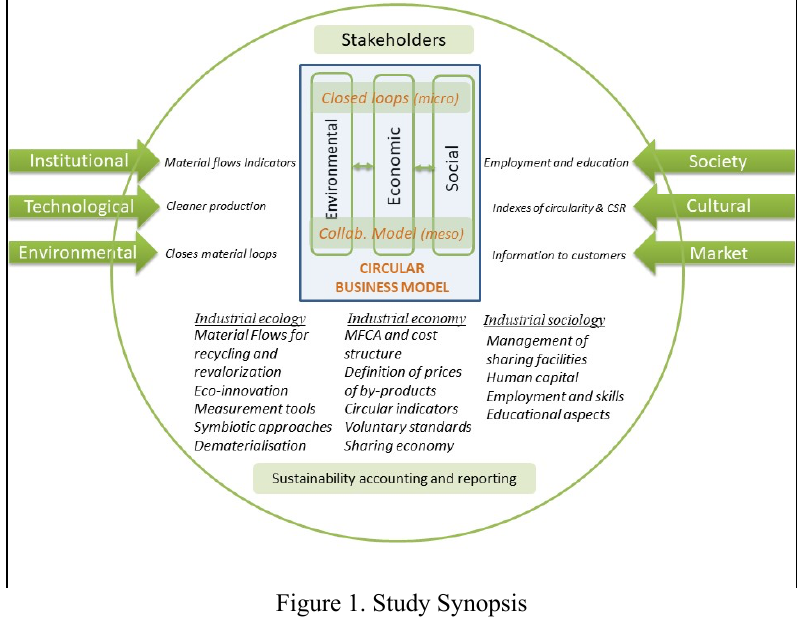
Figure 1. Study Synopsis